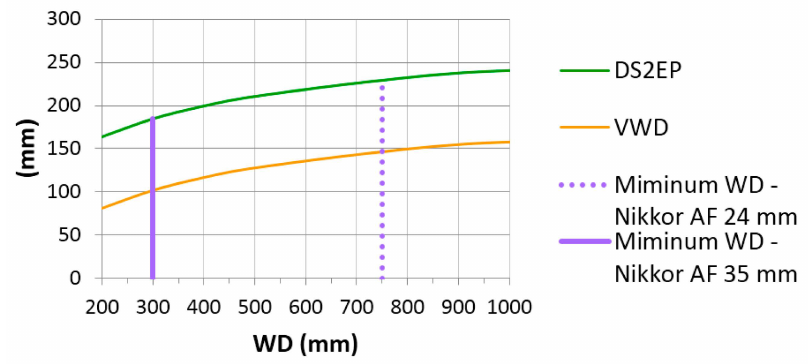
Figure 12. Variation of subject to entrance pupil distance (DS2EP) and virtual working distance (VWD) in function of the working distance (WD). The minimum WD for Nikkor 24 mm and 35 mm focal length are also